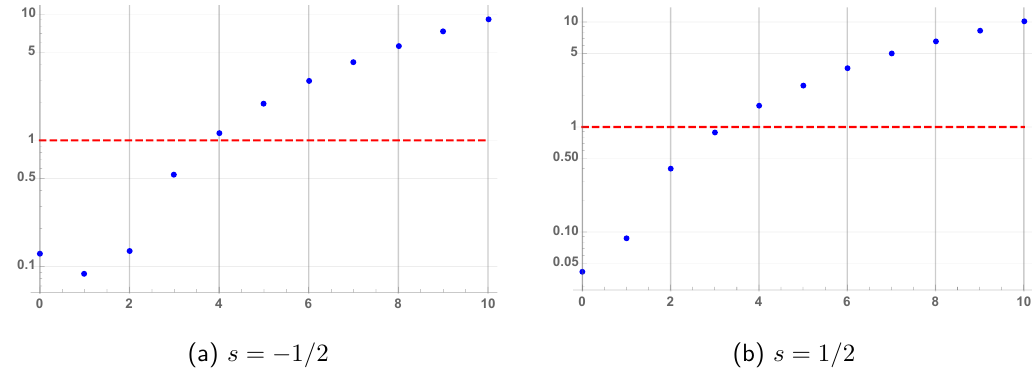
S 2 ) for s = 1 = 2. j (cid:6)